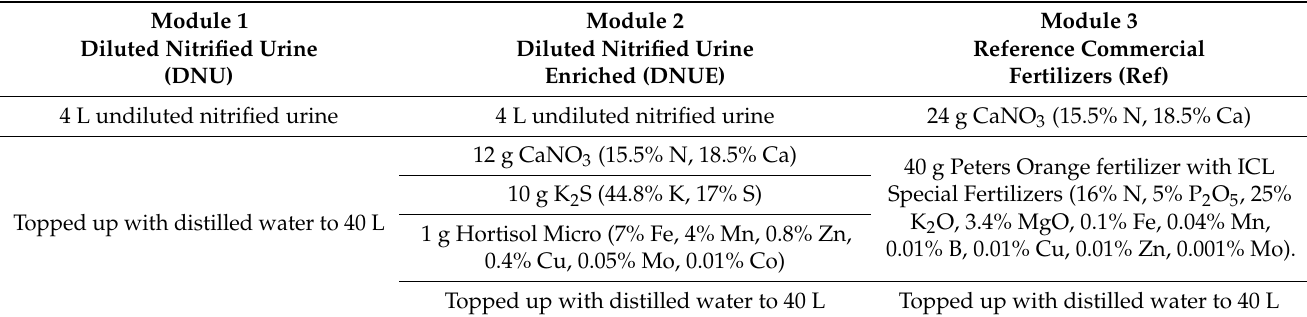
Table 1. The nutrient solutions